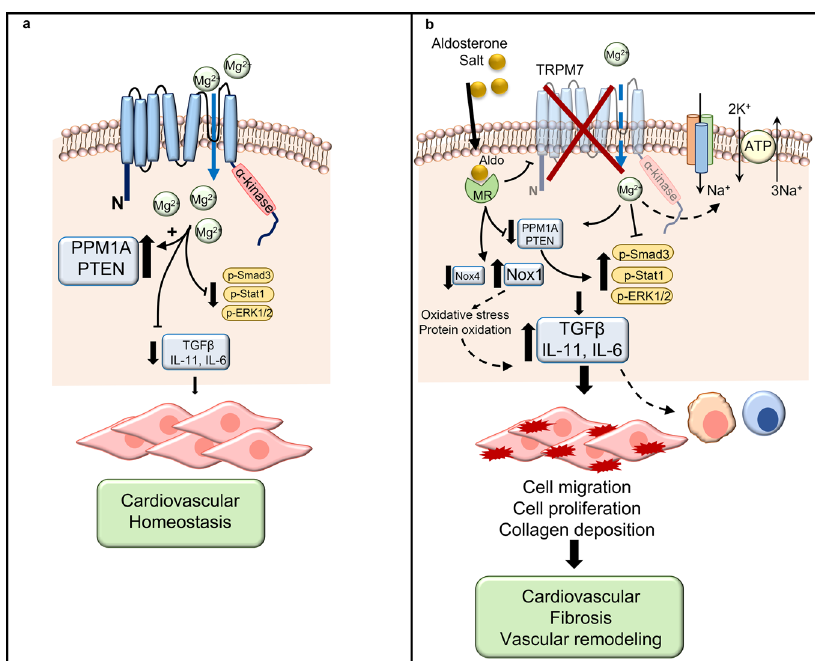
Fig. 8 Interactions between TRPM7, Mg 2 + , and aldosterone/salt. a Under physiologic conditions functional TRPM7 regulates cellular Mg 2 + homeostasis and intracellular free Mg 2 + concentration ([Mg 2 + ]i), which in fl uences signaling molecules, cell function, and cardiovascular homeostasis. b Aldosterone- salt stimulation causes downregulation of TRPM7, with associated decrease in [Mg 2 + ]i. This is associated with reduced activation of phosphatases PPM1A and PTEN; increased production of TGF β , IL-11, and IL-6; increased phosphorylation of proin fl ammatory and pro fi brotic signaling molecules Smad3, Stat1, and ERK1/2; oxidative stress and potential imbalance of electrolytes (Na + and K + ). These mechanisms are involved in cell migration, proliferation, in fl ammation, and collagen deposition, resulting in vascular remodeling and cardiovascular fi brosis. Larger fonts = increased response; Smaller fonts = reduced responses. Arrows-activation; blocked line-inhibition; dashed line-pathways not yet